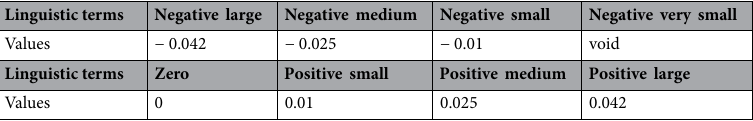
Table 11. Referential values of average pressure difference.